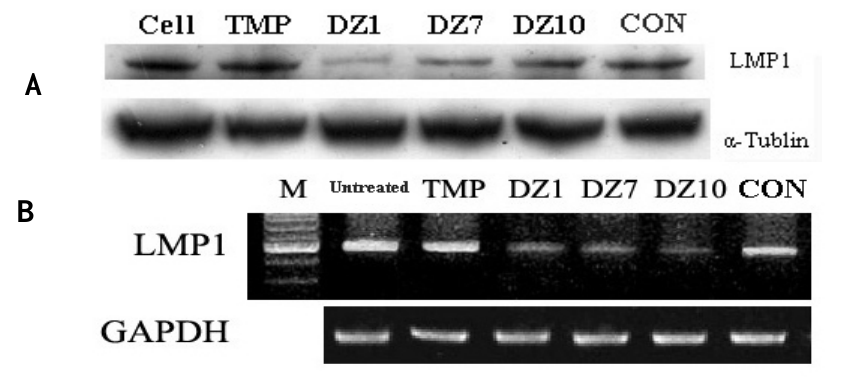
Figure 1. A: Inhibition of LMP1 expression in CNE1-LMP1 cells by DNAzymes. CNE1- LMP1 cells were transfected with DNAzymes or control ODN, total cell lysates and RNA were analyzed by Western blot (A) and RT-PCR